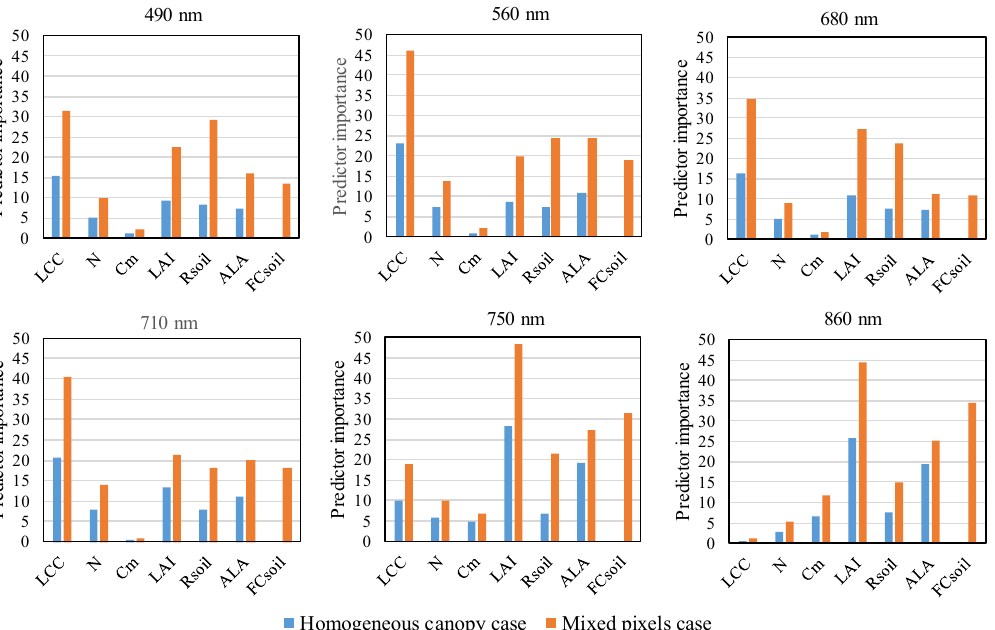
Figure 3. Variable importance analysis for canopy reflectance at different wavelengths in the two cases of a homogeneous canopy and vegetation-soil mixed pixels.